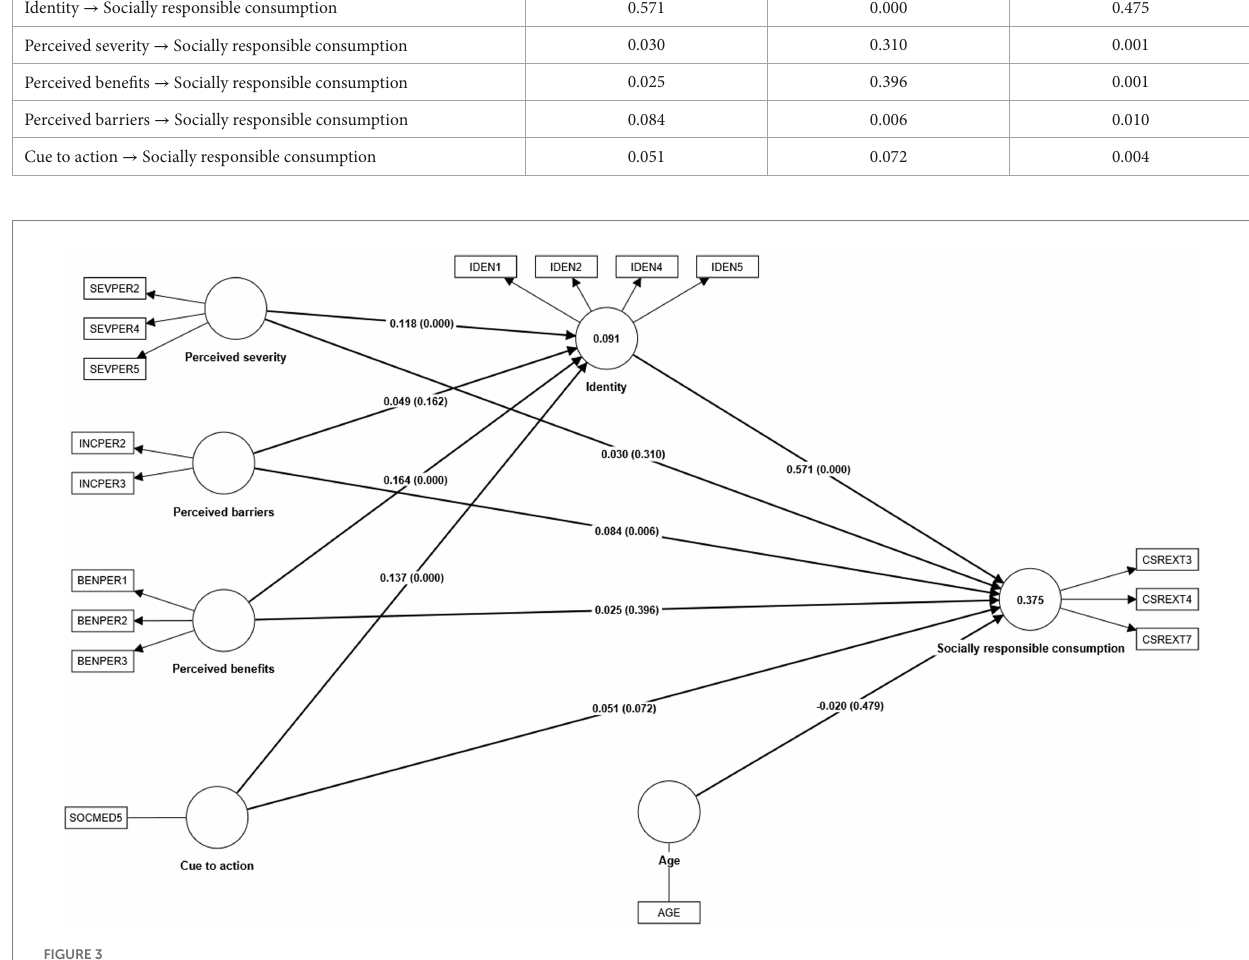
FIGURE 3 Alternative conceptual